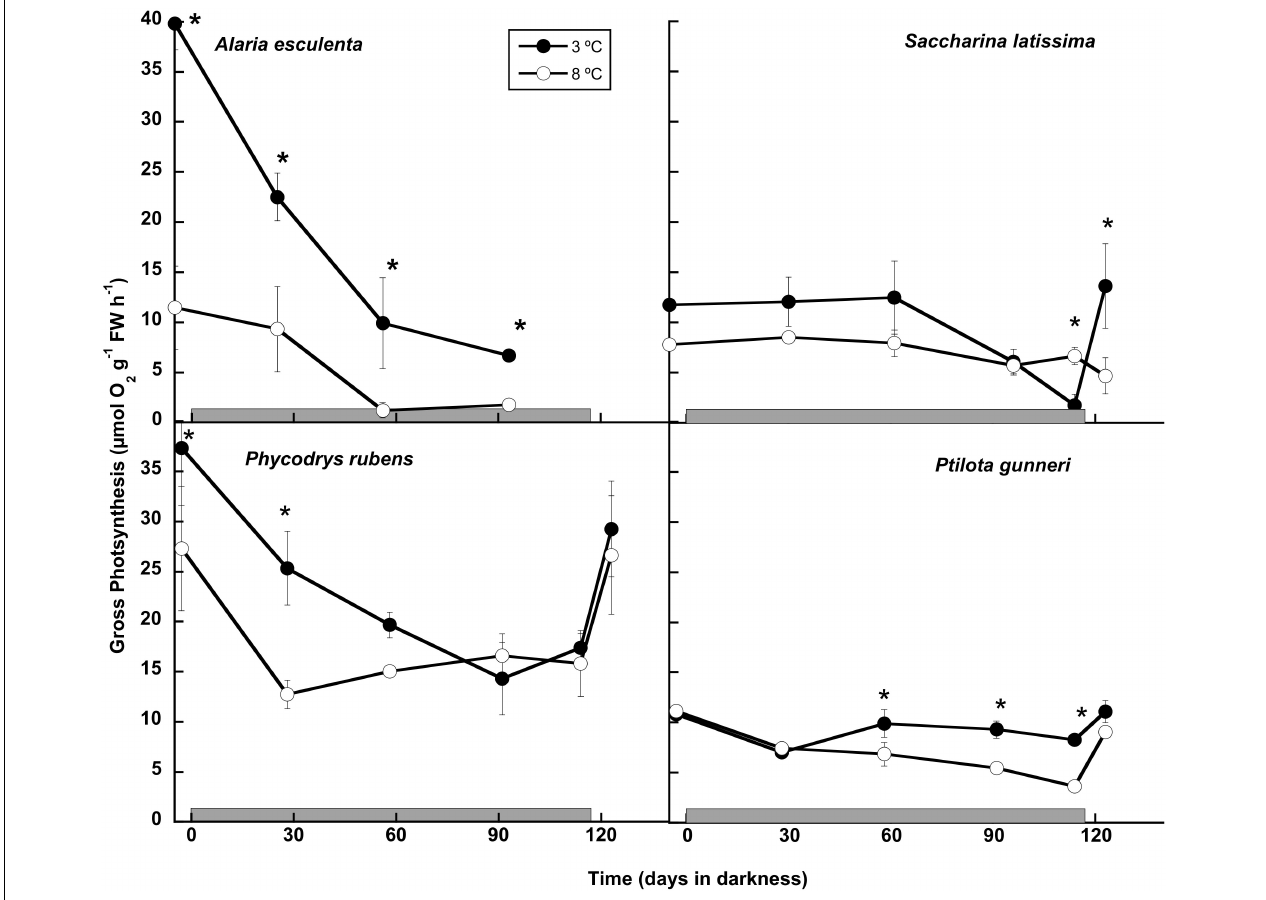
FIGURE 4 | Gross photosynthetic rate measured as O 2 production during the 16 weeks of incubation in darkness (gray horizontal bar) of Alaria esculenta , Saccharina latissima , Phycodrys rubens , and Ptilota gunneri at two different temperatures. Data are mean of 3 replicates (error bars for standard deviation). Significant differences between temperatures marked with an asterisk. See details for photoperiod in the